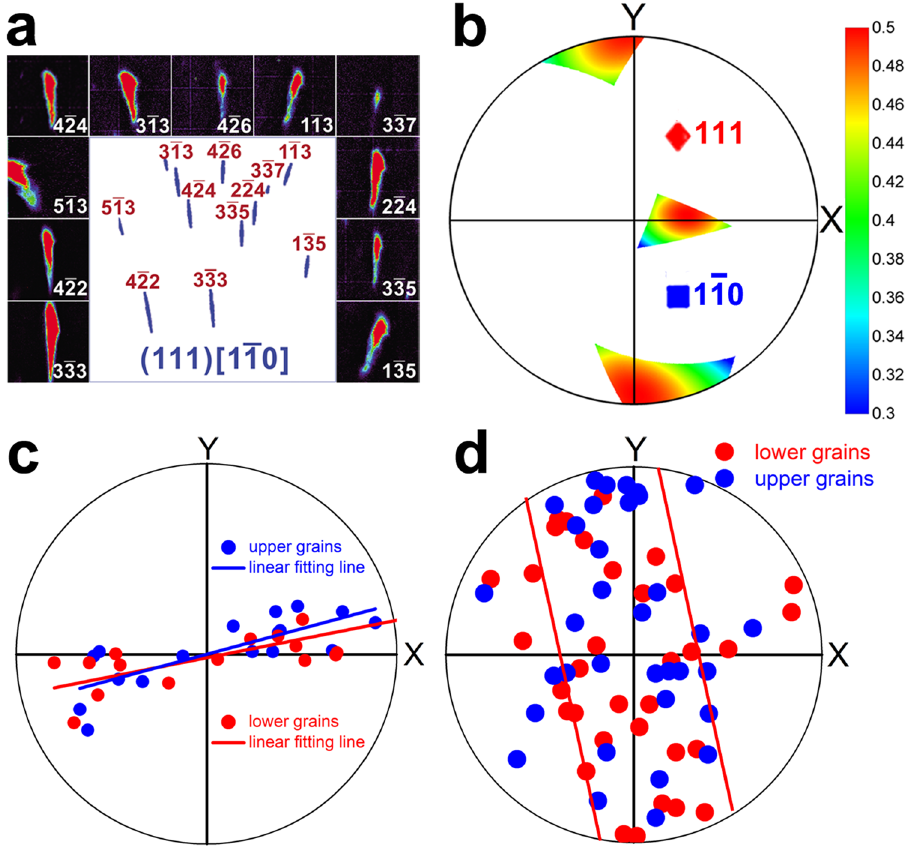
Figure 5. Statistical study of the dislocation slip systems of the crystal grains adjacent to the crack. ( a ) Dislocation slip system study for Grain #9. The simulated streaking Laue peaks with (111)/[1–10] GNDs are displayed surrounding the experimental observed Laue diffraction pattern. ( b ) The calculated Schmid factor as a function of equivalent uni-axial tensile stress direction. ( c ) Stereographic projection on XY plane of the dislocation line directions in investigated grains above (blue) and below (red) the crack, respectively. ( d ) Stereographic projection of the equivalent uni-axial tensile stress direction in each of the forty grains calculated according to Schmid’s